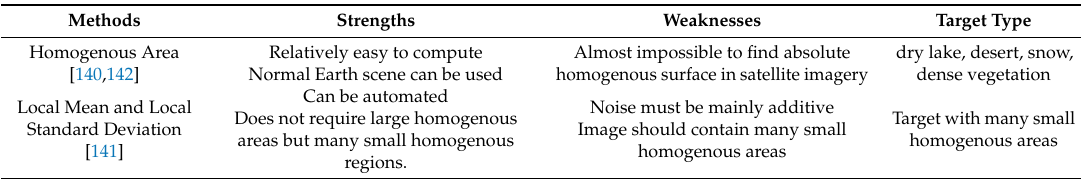
Table 4. SNR estimation